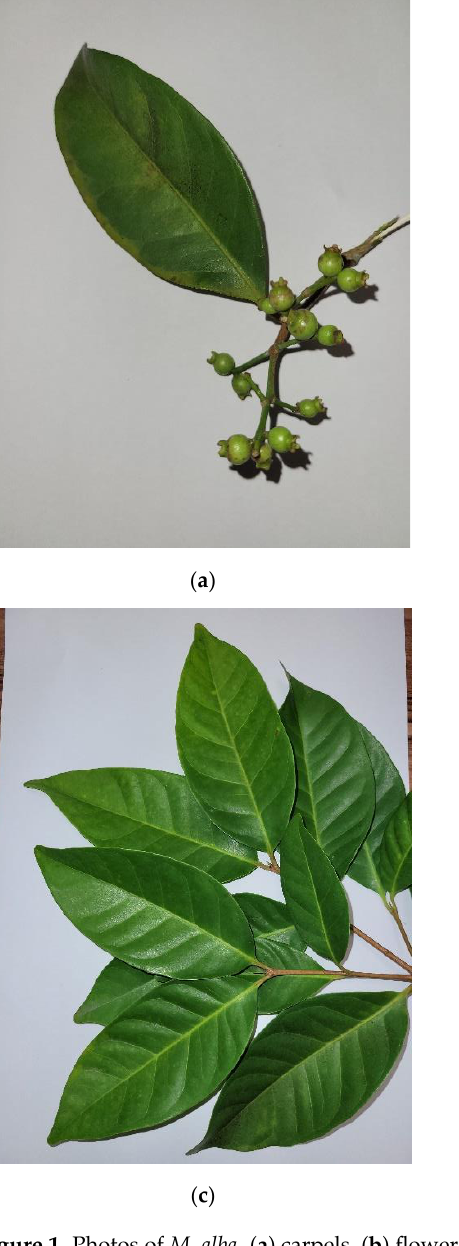
Figure 1. Photos of M. alba . ( a ) carpels, ( b ) flower, ( c ) leaves, and ( d ) M. alba plant (photo taken on M. alba planted in Universiti Teknologi Malaysia Pagoh Campus).